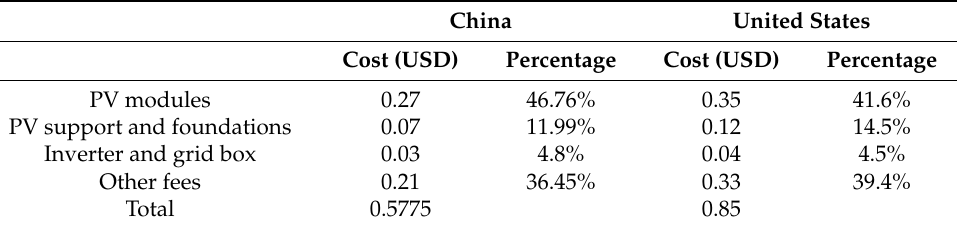
Table 1. Investment cost percentage of solar farms [1,2].